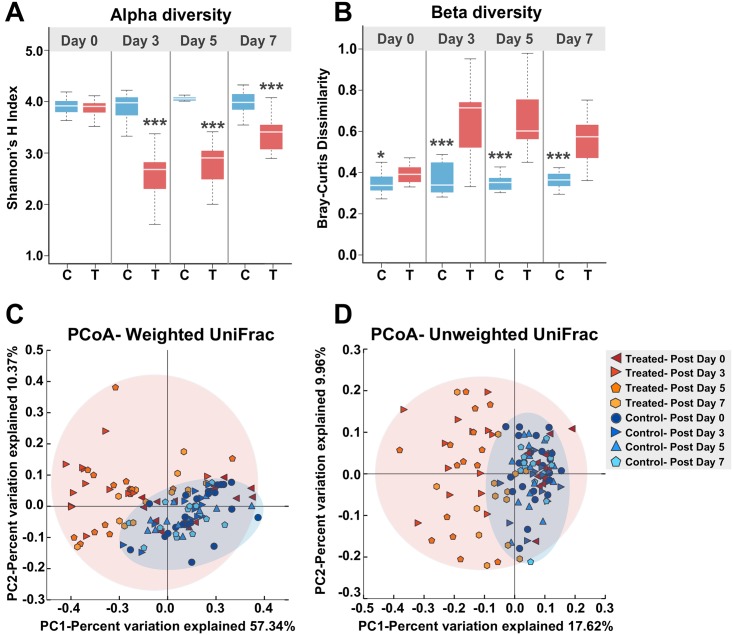
Alpha and beta diversity of treatment and control bees.A) Difference in alpha diversity between control and treatment bees at each time-point (measured as Shannon’s H). B) The average Bray-Curtis dissimilarity in gut communities among control bees versus between control bees and treatment bees. Box-and-whisker plots show high, low, and median values, with lower and upper edges of each box denoting first and third quartiles, respectively. * = p < 0.05 and *** = p < 0.0001, Wilcoxon rank sum tests. C) Principal coordinate analysis using unweighted UniFrac. D) Principal coordinate analysis using weighted UniFrac. See S3 Data for alpha and beta diversity data.